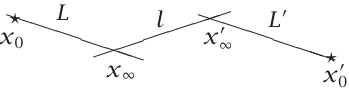
= A 4 Hilb (o) for G